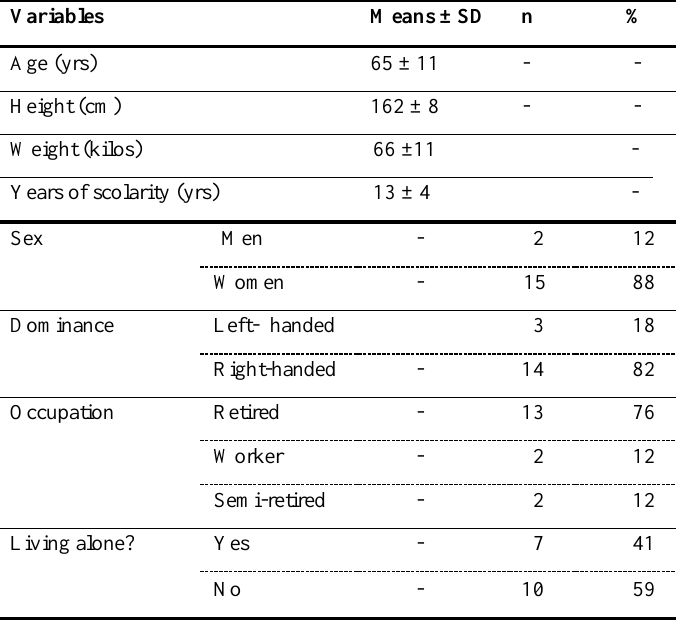
Table 1. Participants’ C haracteristics